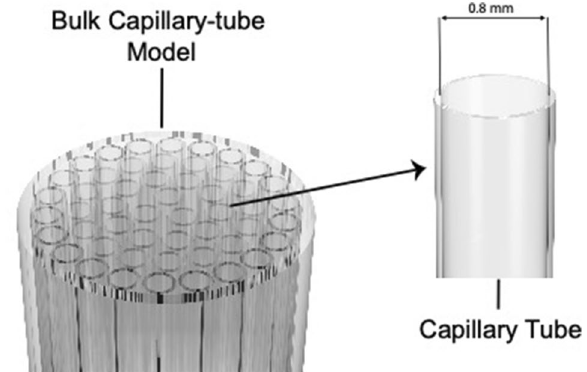
Figure 10. Silica-glass bulk model consisting of capillary tubes with constant diameters of 0.8 mm.